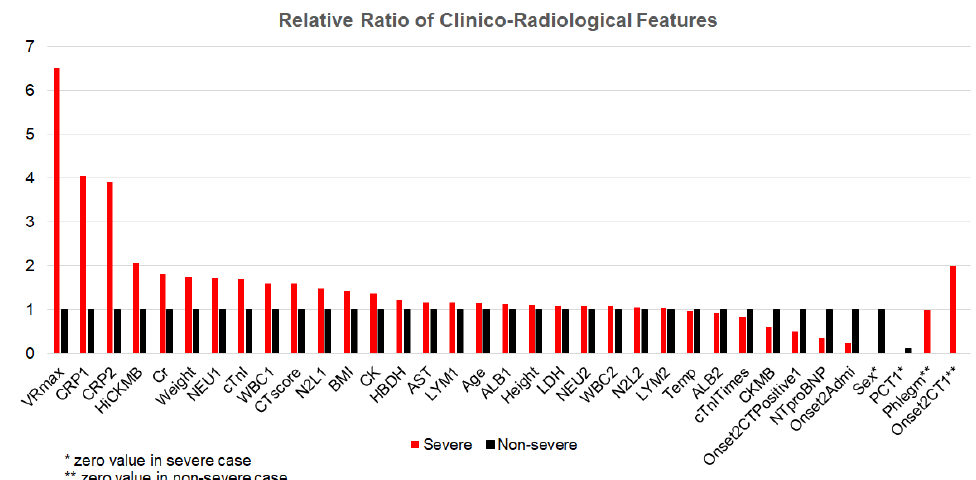
Figure 3. Comparison of clinico-radiological features between a non-severe case and a severe case. The values of features in the severe case are in relative value of corresponding values in the non-severe case, except those with zero values (Sex, PCT1, Phlegm, and Onset2CT1).